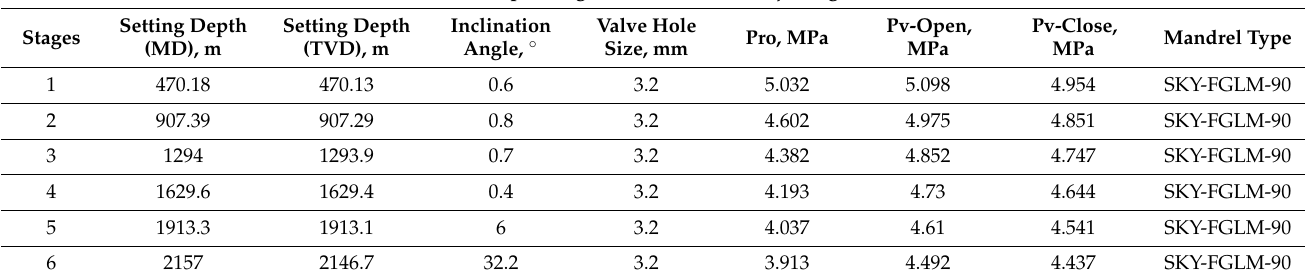
Table 4. Setting depth of gas lift valve—FL-2HF.